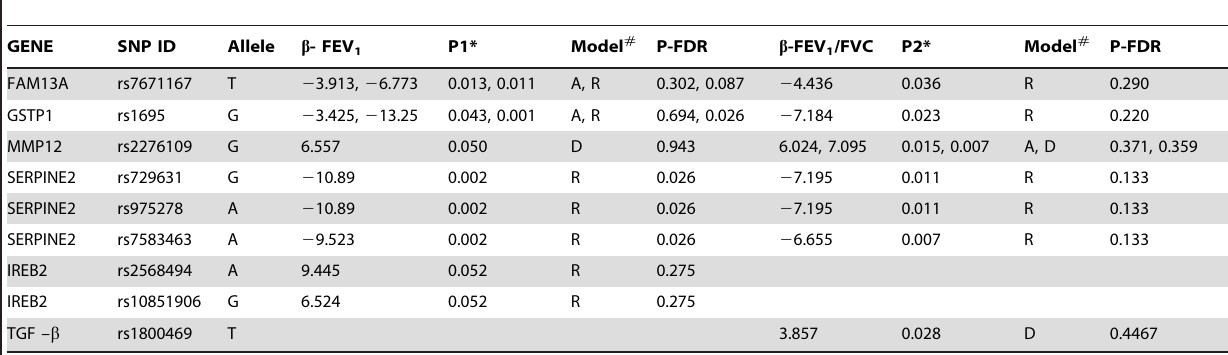
Table 2. Single nucleotide polymorphisms showing association with COPD phenotypes.